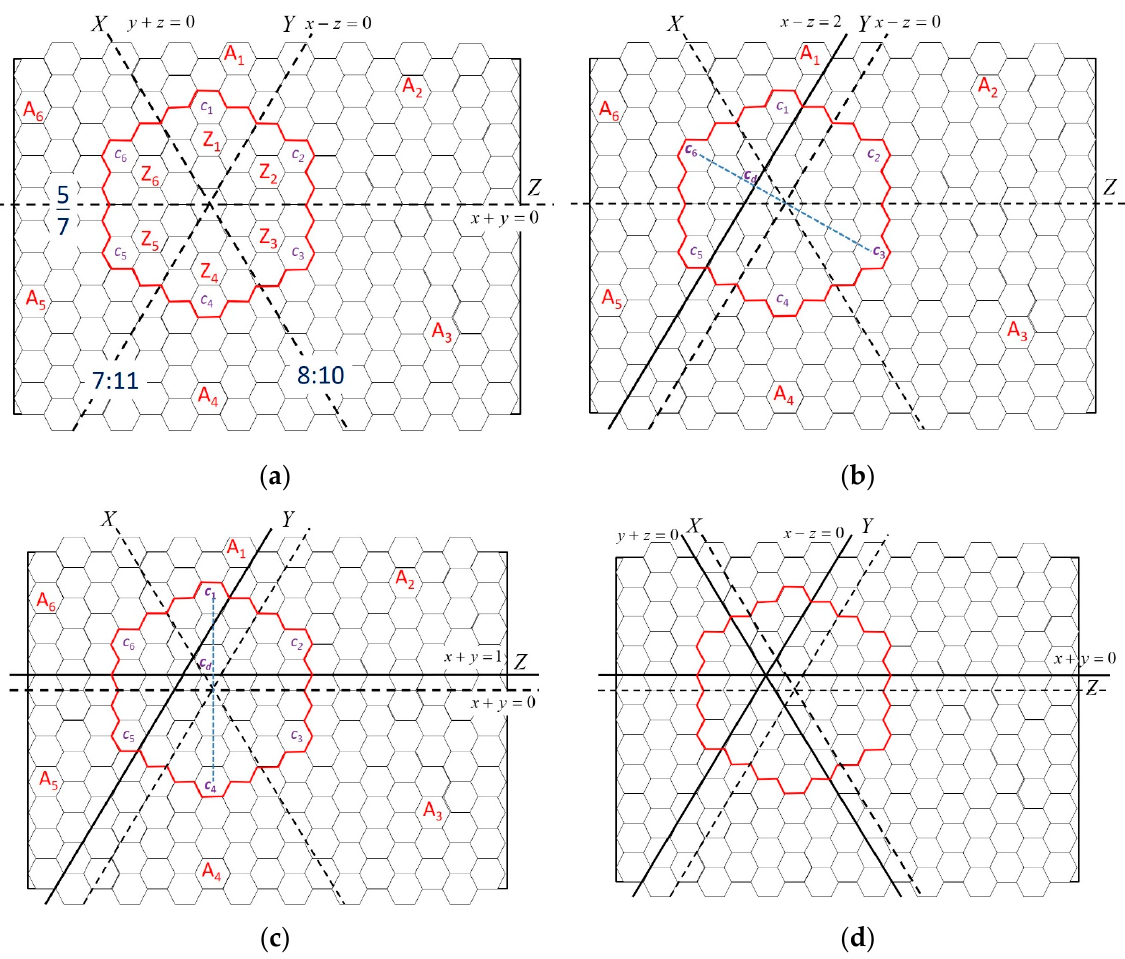
Figure 2. ( a ) Initial origin at the center of the charging zone; ( b ) Y-axis is adjusted to satisfy energy requirements; ( c ) Z-axis is adjusted to satisfy energy requirements; ( d ) X-axis is adjusted to orientate the origin, and the axes are fi xed.